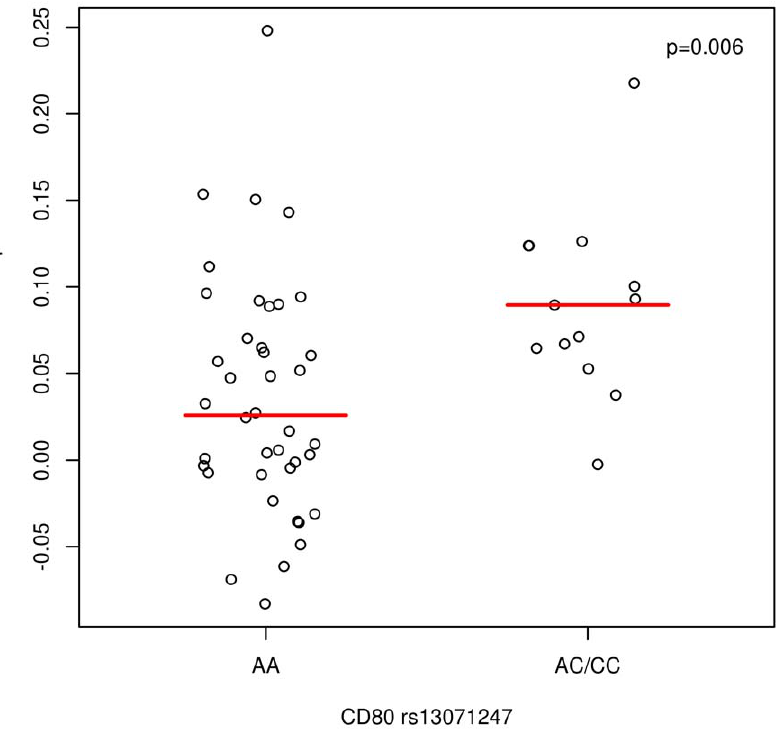
Figure 1. CD80 rs13071247 Genotype and Tumor Expression. Among N=54 MAY + MAC invasive ovarian cancer cases, Agilent whole human genome 4 6 44 K expression array probe A_24_P155632; CD80 log 2 ratios of tumor versus reference RNA expression (y-axis) versus genotype (x-axis); dashes indicate median; each symbol represents a unique patient; data points are jittered so all data are visible.